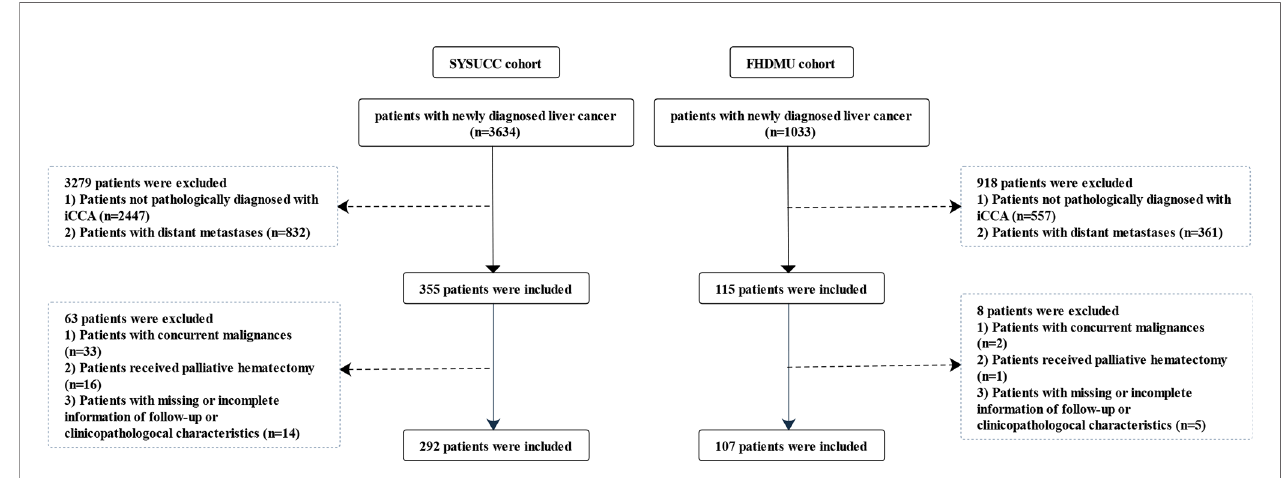
FIGURE 1 | Flow chart of the patient enrolling